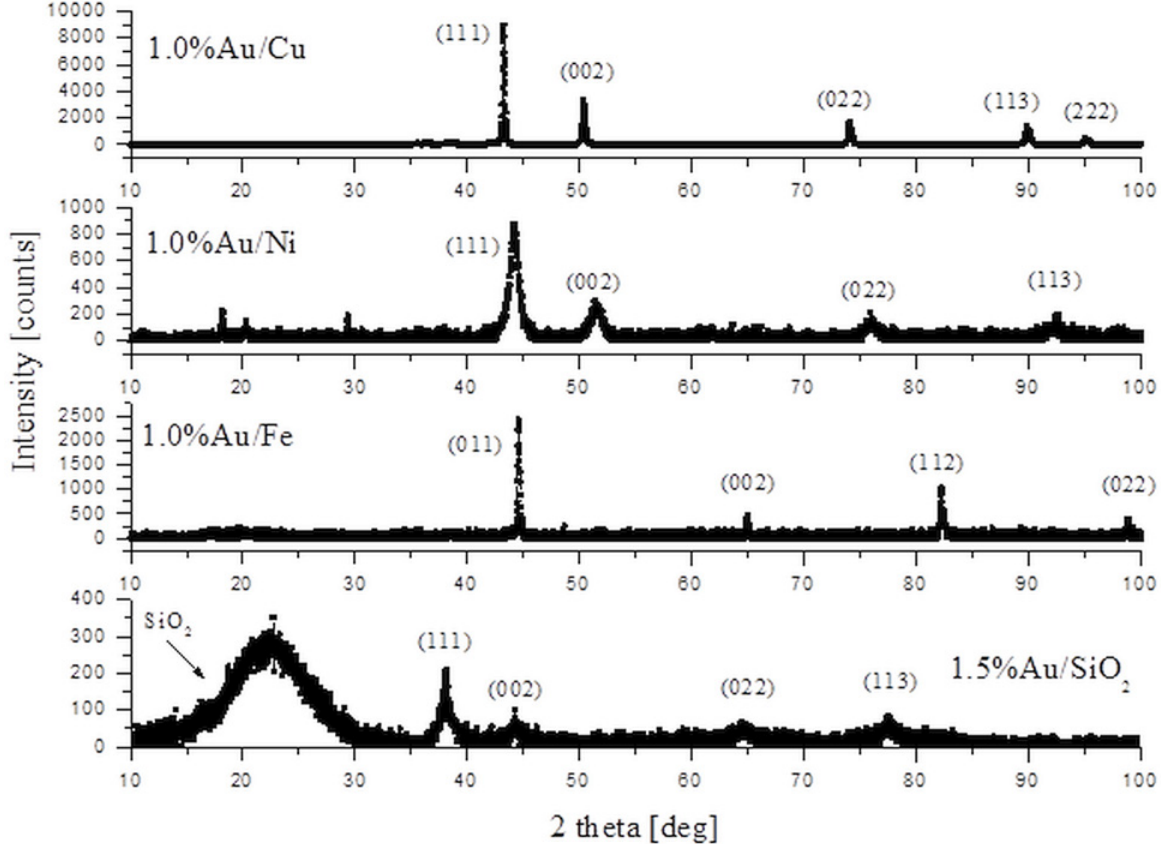
Fig 4. The X-ray diffraction patterns of 1.0%Au/Cu, 1.0%Au/Ni, 1.0%Au/Fe and 1.5%Au/SiO 2 samples. Miller indices for experimental peaks are